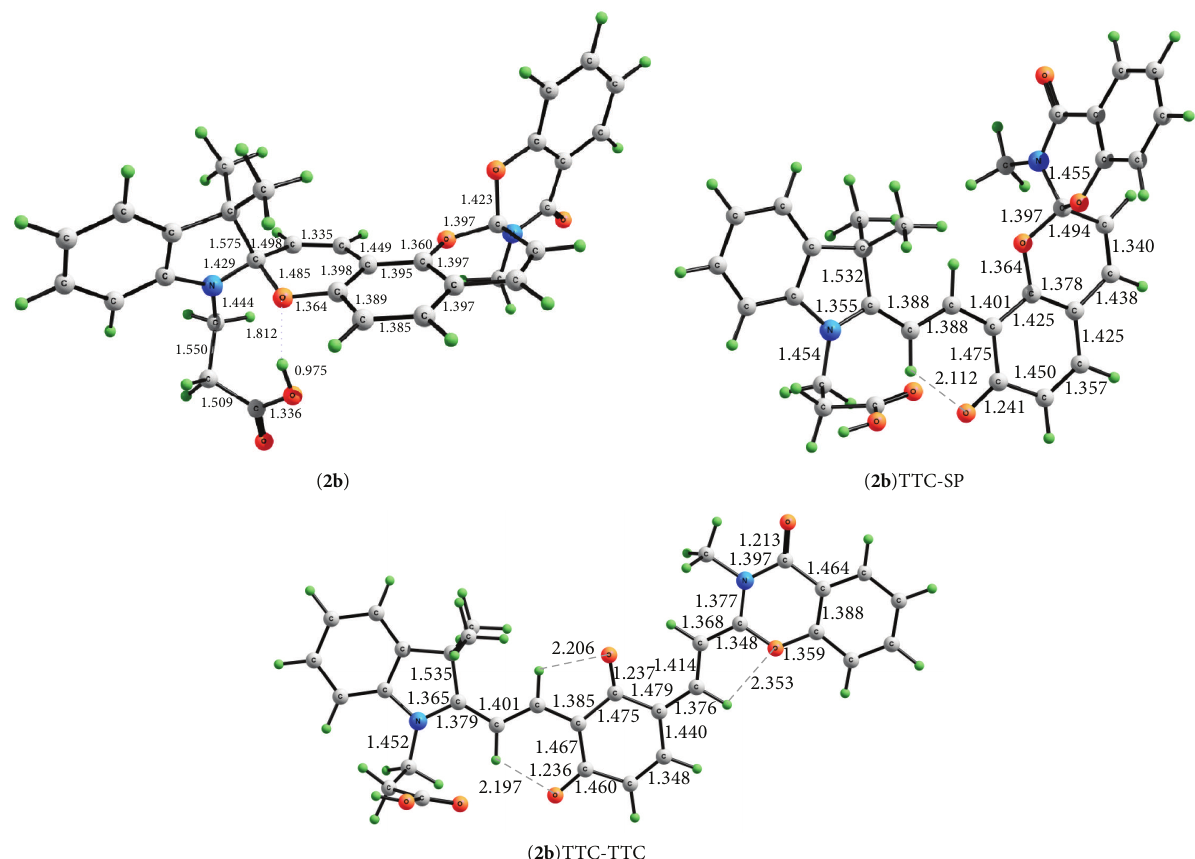
Figure 5: Structural properties of ( 2b ) and its merocyanine isomers ( 2b )TTC-SP j and ( 2b )TTC-TTC calculated at the CPCM/PBE0/6- 311G ∗∗ level of theory (acetonitrile solutions).